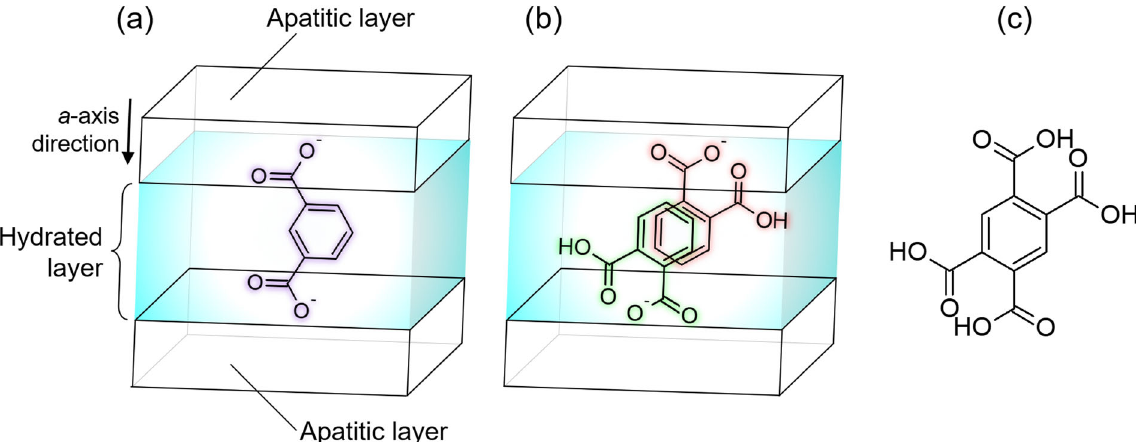
Fig. 1 Schematic representation of interlayer structures and molecular structures of carboxylic acids. Interlayer structures of OCP incorporated with